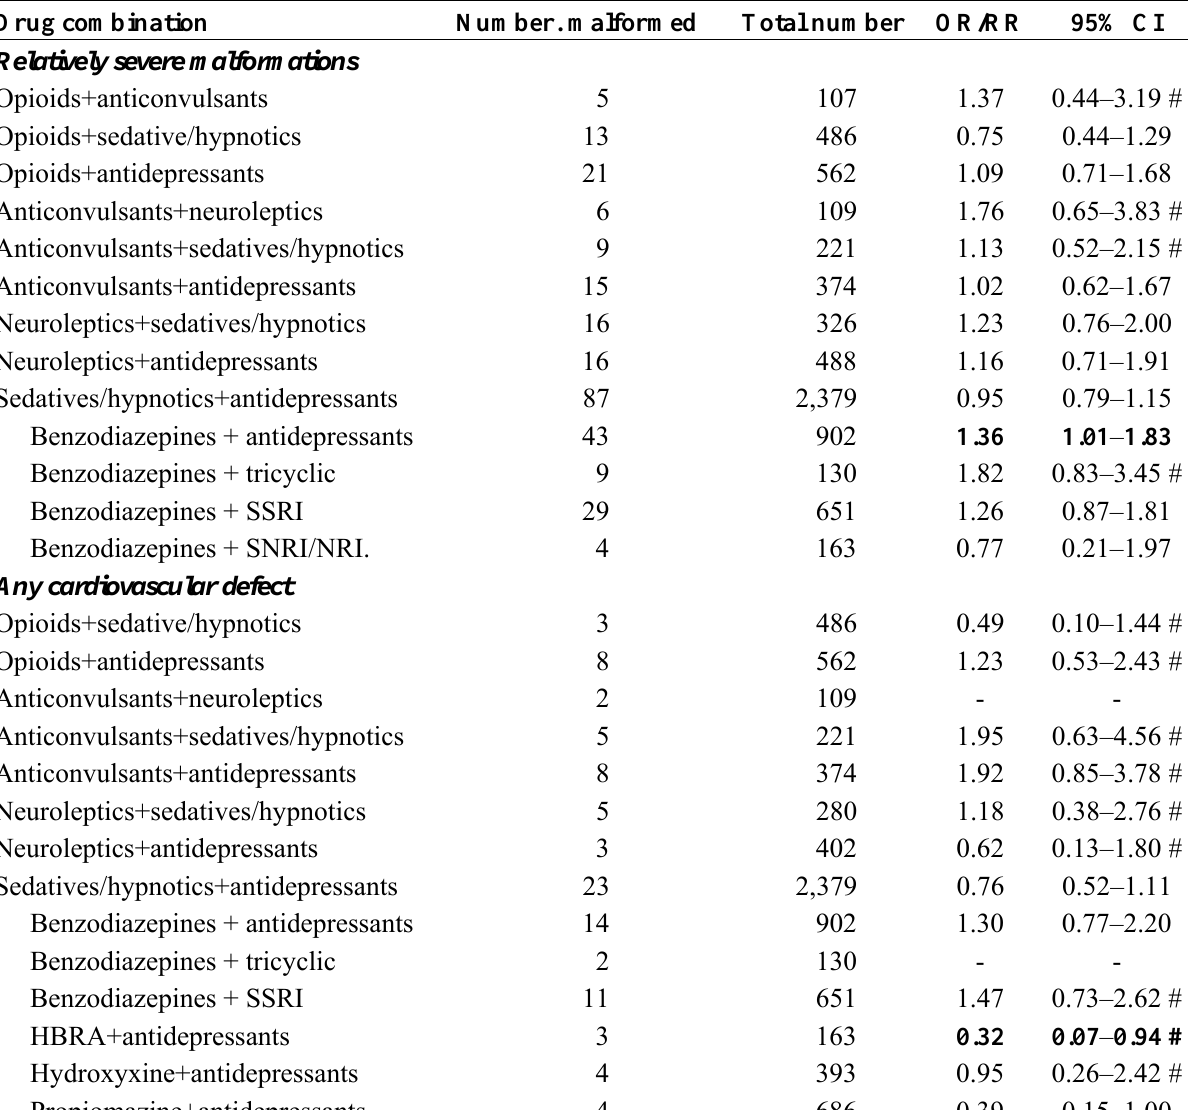
Table 42. “Relatively severe malformations” and cardiovascular defects after combined use of different CNS active drug groups. Neuroleptics exclude dixyrazine and prochlorperazine. Bold text marks statistical